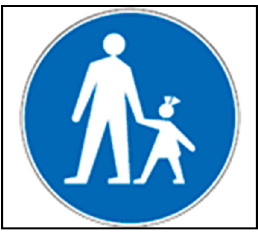
Figure 4. The traffic sign “Walking trail” (II-41). The fourth color used in the research is yellow. The specified color is used for temporary traffic signals in the road works zone (e.g., Figure 5).